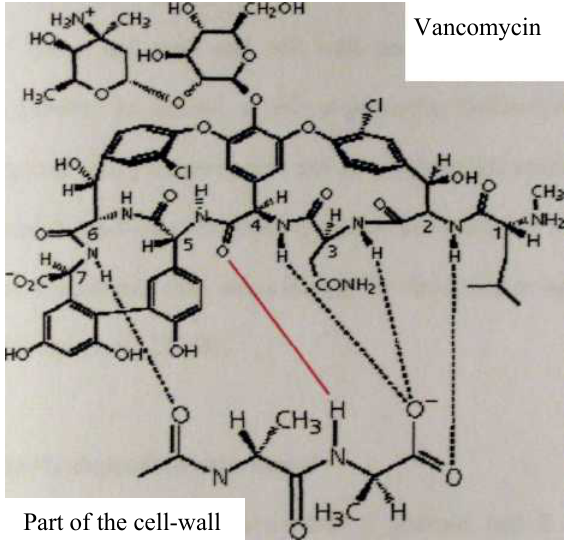
Figure 2. Binding of vancomycin to D-Ala-D-Ala, and the structure of the altered pre- cursor,